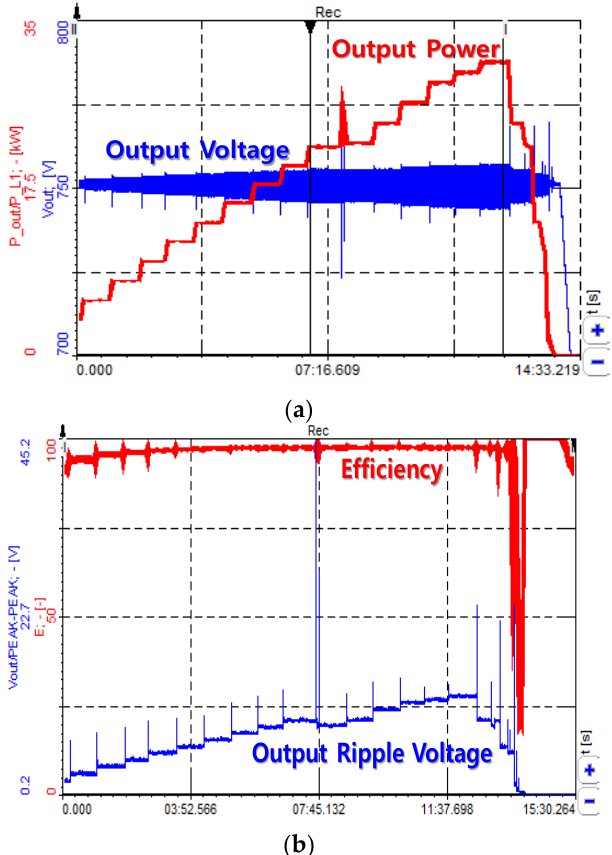
Figure 5. Waveforms resulting from the performance test of the AC/DC power converter. ( a ) Figure5. WaveformsresultingfromtheperformancetestoftheAC / DCpowerconverter. ( a )Maintaining Maintaining output voltage during a load change. ( b ) Efficiency and output power ripple during a output voltage during a load change. ( b ) E ffi ciency and output power ripple during a load load change. Table 5. Results of the AC/DC power converter performance test.